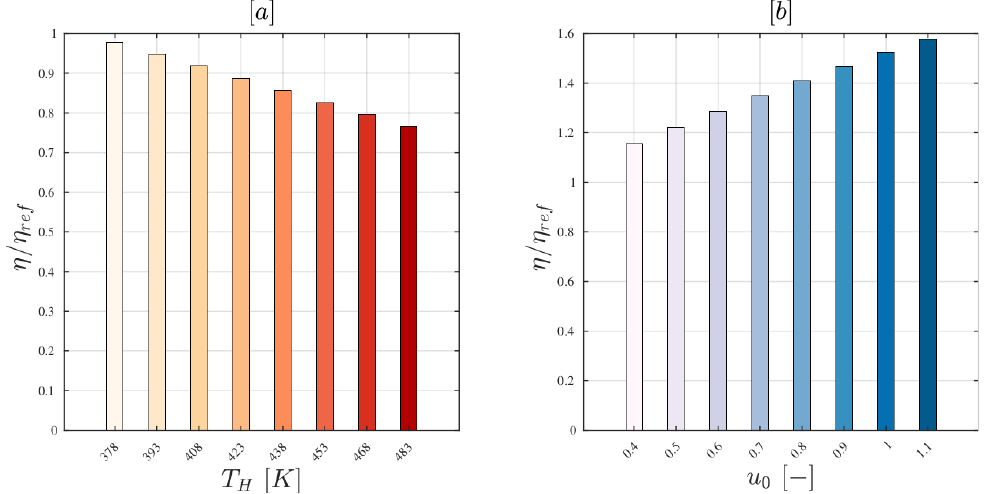
Figure 3. Drying efficiency at different temperatures T H ( a ) and initial moisture contents u 0 ( b ) com- pared to the efficiency ( η ref ) of